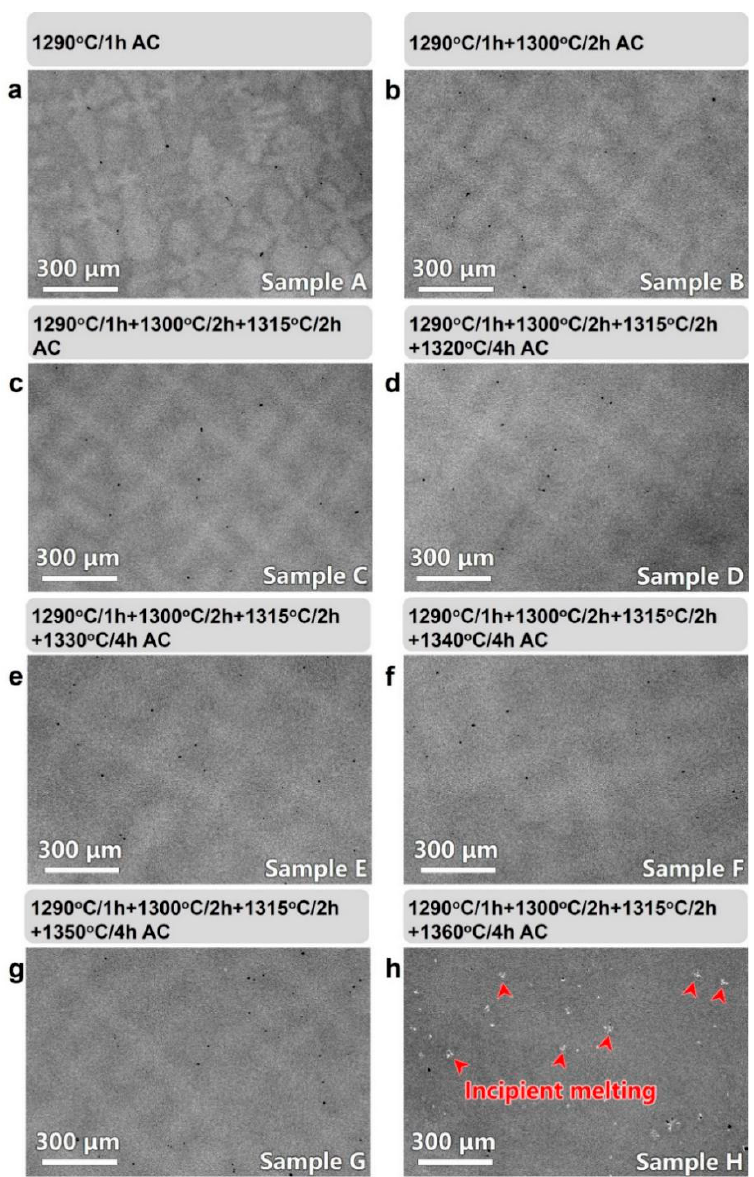
Figure 5. Dendritic segregation in samples after different solid solution heat treatments (i.e., Table 2). ( a–h ) The contrast of the dendrite arm decreases as the solution treatment temperature and time increase; ( h ) Incipient melting is clearly observed at temperature of 1360 °C. The heat treatment detail of each sample is shown at the top of each backscattered electron (BSE) image. Note that black dots are shrinkage cavities.